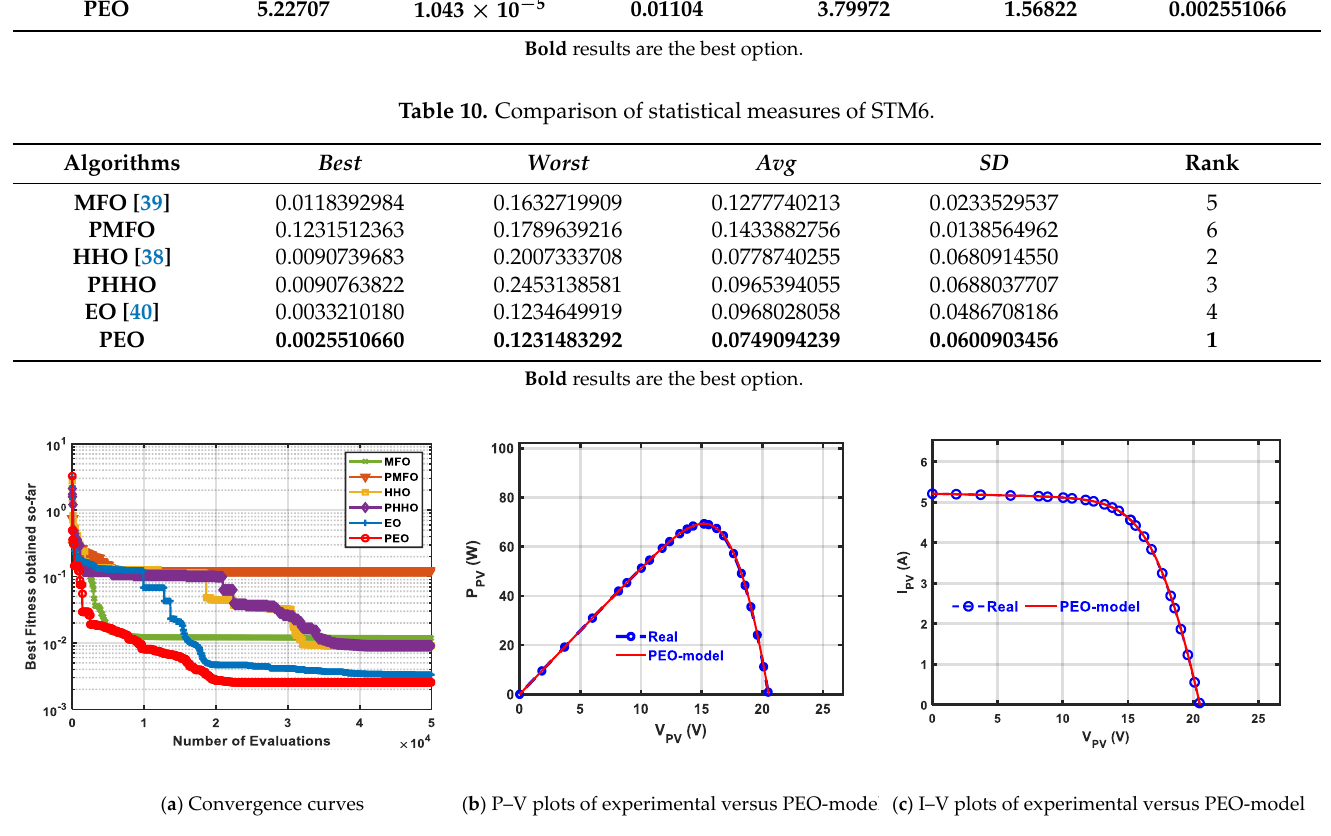
Figure 10. Graphical depictions of the performance of the algorithm in Ultra 85-P.